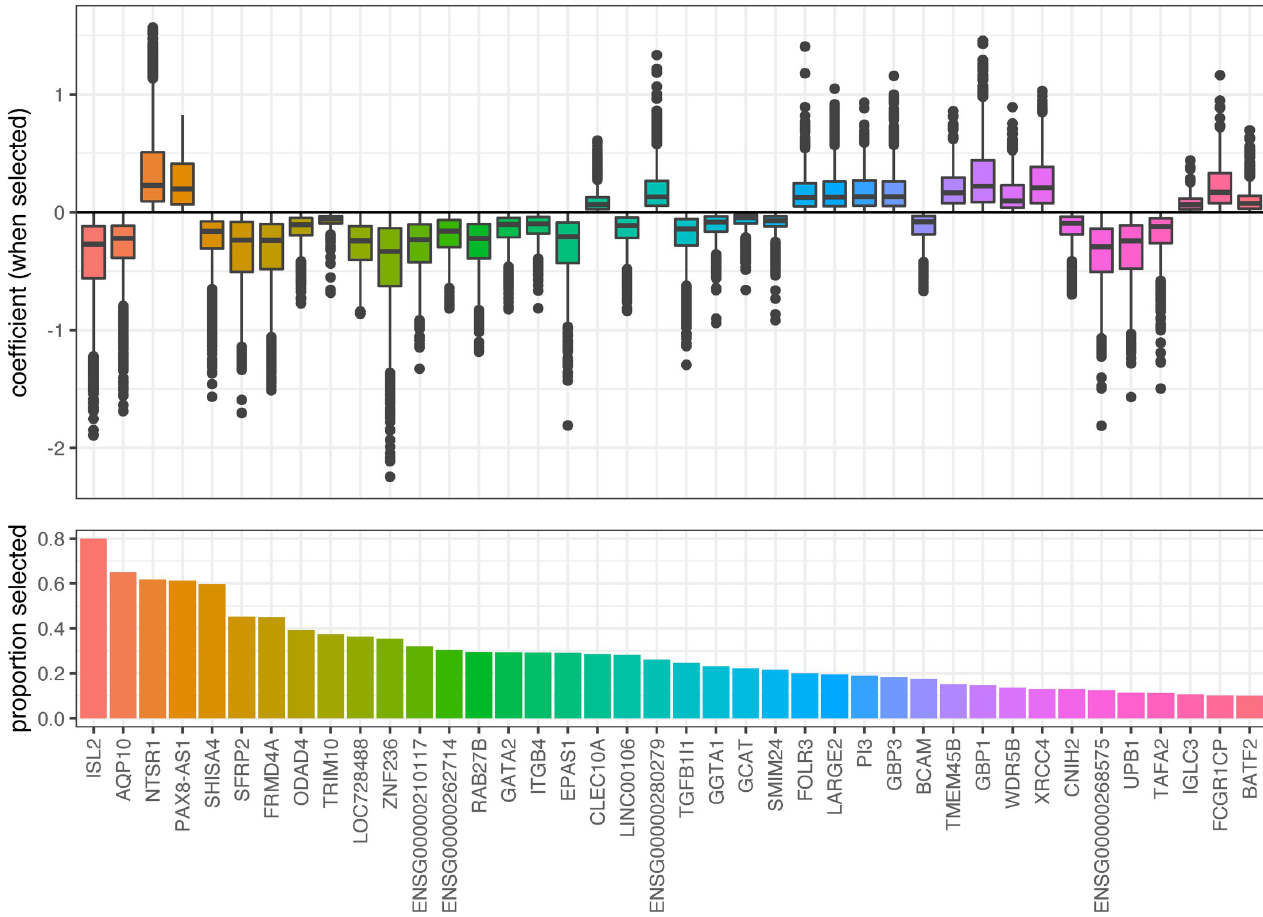
Fig 3. LASSO regression training results for the prediction of any CMV DNAemia. For each of 100 iterations, 57 models were trained to predict any CMV DNAemia. The bottom panel shows the proportion of all fits that selected each gene or transcript, and the top panel shows boxplots of the coefficients, when the corresponding terms were selected for inclusion. The genes and transcripts shown are those that were selected in 10% or more models. They are sorted in decreasing order of selection frequency, and are labeled with their gene symbol when available or the Ensembl ID.